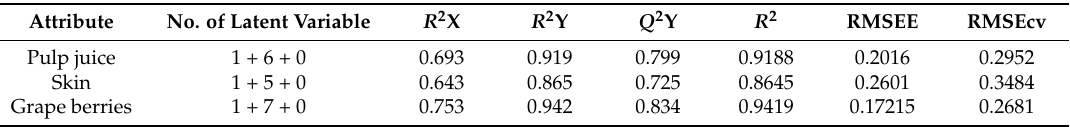
Table 1. Summary of the results of orthogonal partial least squares (OPLS) model developed for pulp juice, skin, and whole-grape